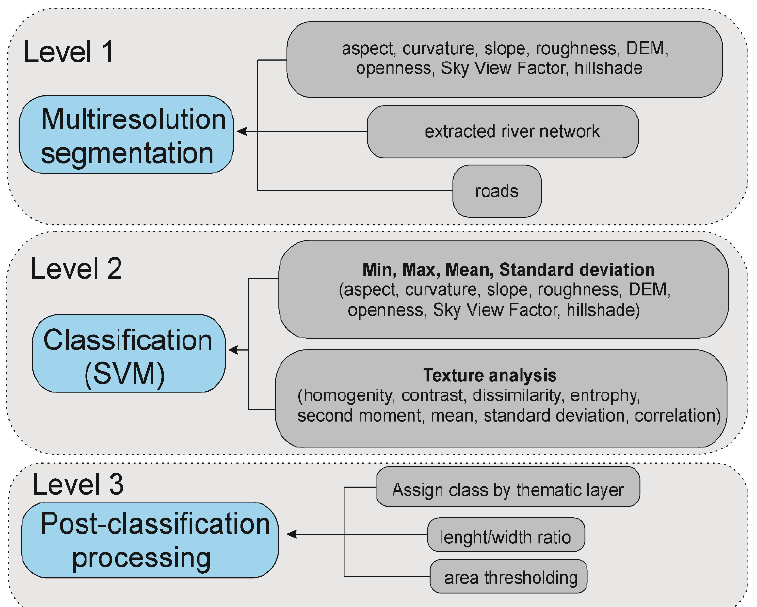
Figure 4. Detailed OBIA methodology divided into three crucial levels.